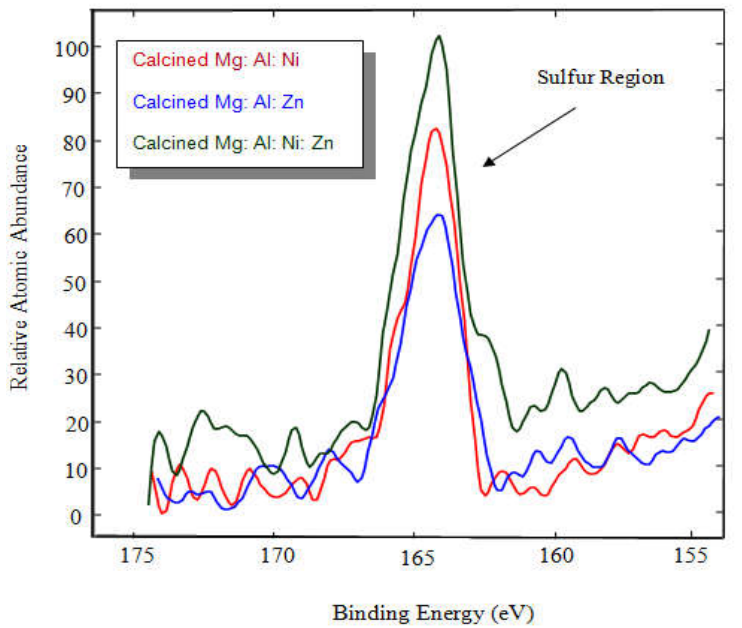
Figure 6. Adsorptive studies of dibenzothiophene. Table 4. Relative percent abundances of species from XPS.